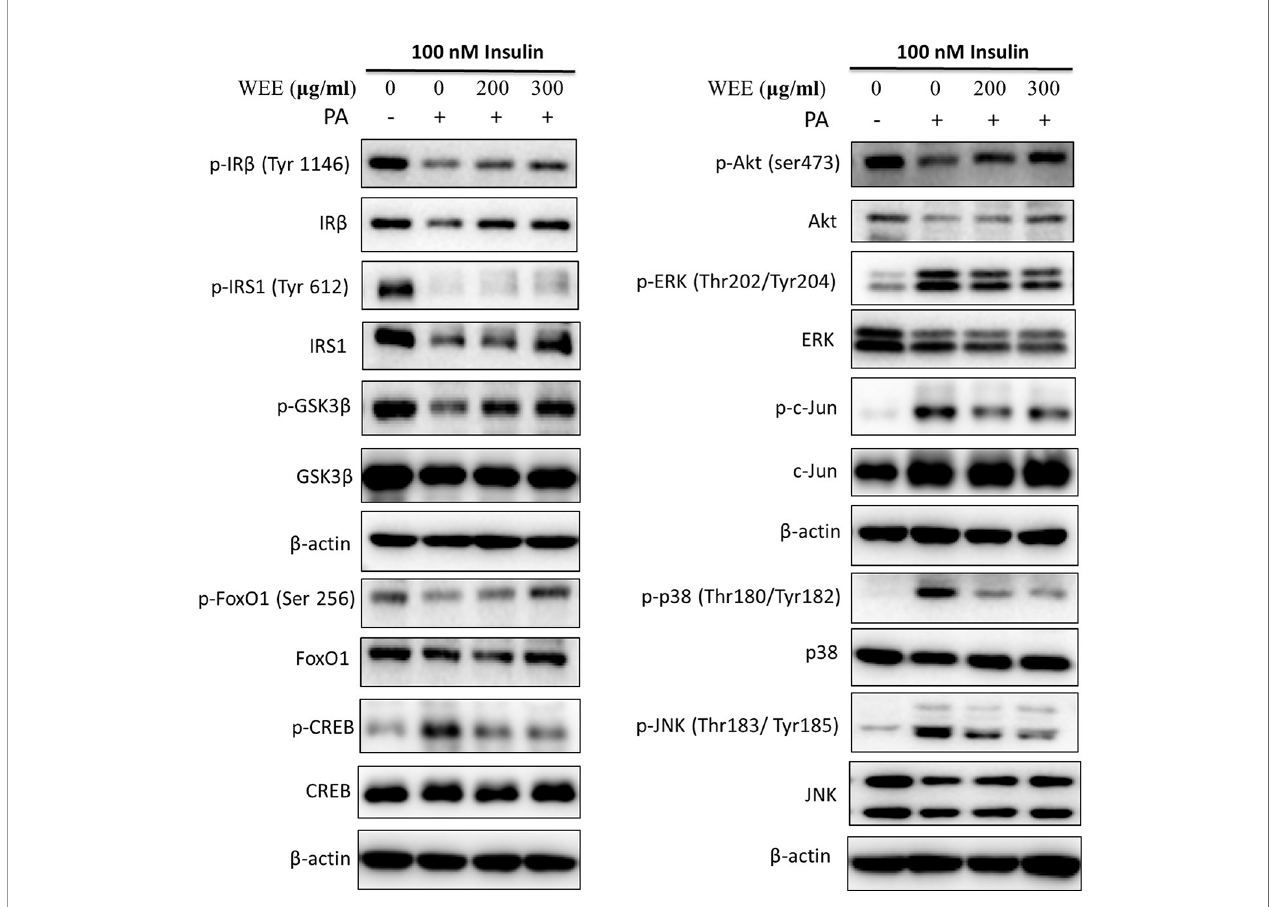
FIGURE 5 | WEE improved the impairment of insulin signaling induced by PA treatment in HepG2 cells. HepG2 cells were incubated with normal glucose (5.5 mM) or high glucose (30 mM) plus PA (0.3 mM) in the absence or presence of WEE (200 and 300 m g/ml) for 24 h and followed by stimulated with insulin (100 nM) for 20 min. Then, the total and phosphorylated forms of IR b , IRS-1, GSK3 b , CREB, c-Jun, FoxO1, Akt, p38, JNK, and ERK were detected by Western